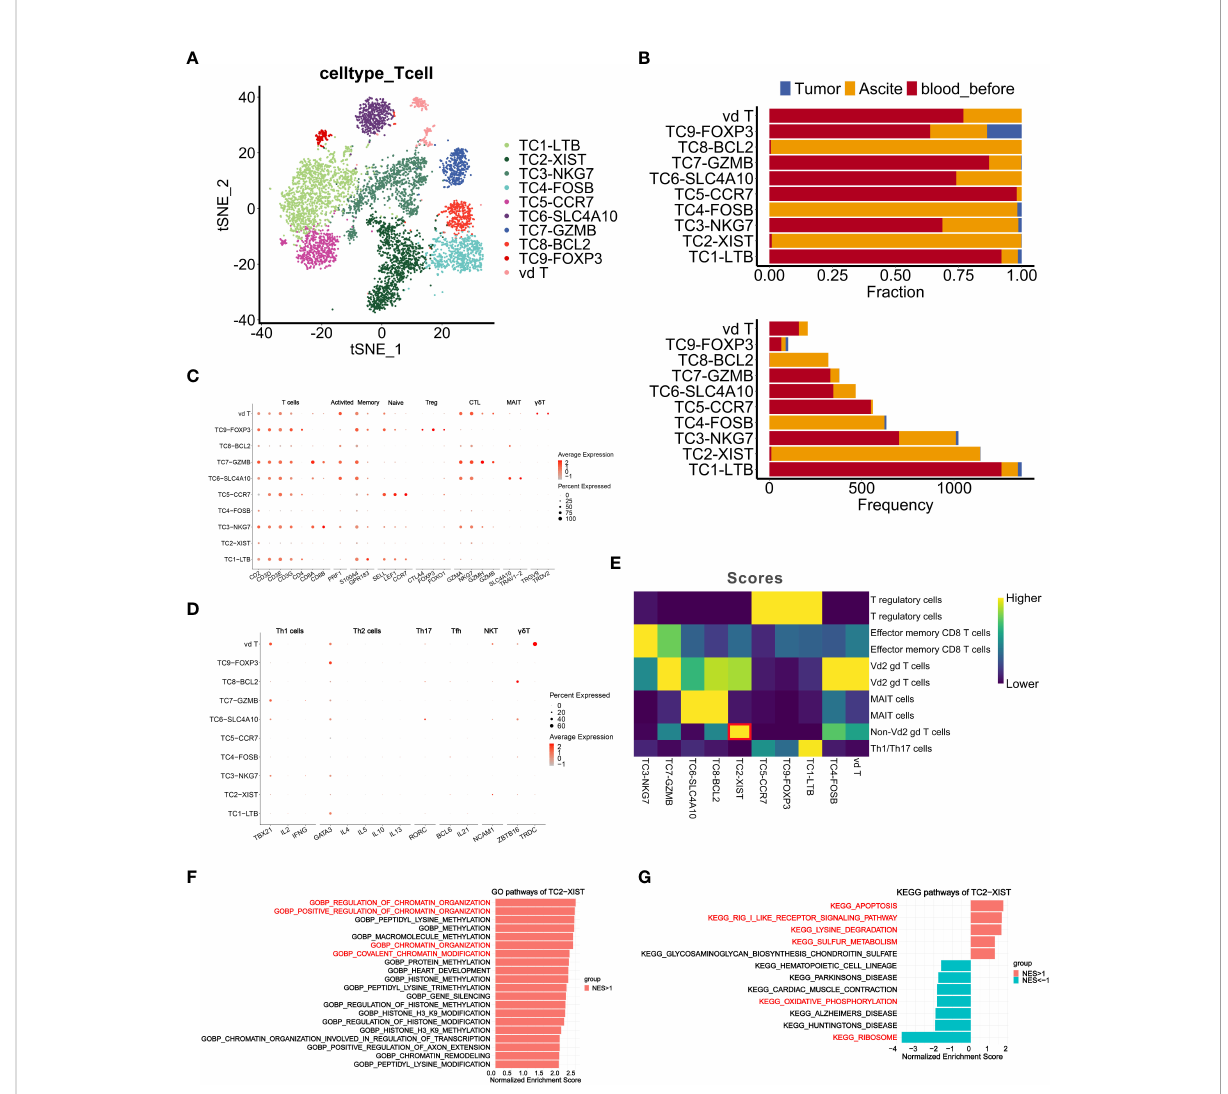
FIGURE 4 Characteristics and dynamics of T cells from samples before chemotherapy at single-cell resolution. (A, B) t-SNE visualization of T cell clusters from samples ( Tumor, Ascite, blood_before ) before chemotherapy, colored by the identi fi ed T cell subclusters. (B) Fraction and frequency of T cells (x axis) from samples ( Tumor, Ascite, blood_before ) in each T cell subcluster (y axis). (C, D) Dot plots show expression level of signature genes in each T cell subcluster. (E) Heatmap shows the classi fi cation result of each T cell subclusters using singleR. (F, G) Gene set enrichment analysis of T cell subcluster TC2-XIST using GO gene sets (F) and KEGG gene sets (G) . Pathway enrichment is expressed as normalized enrichment score